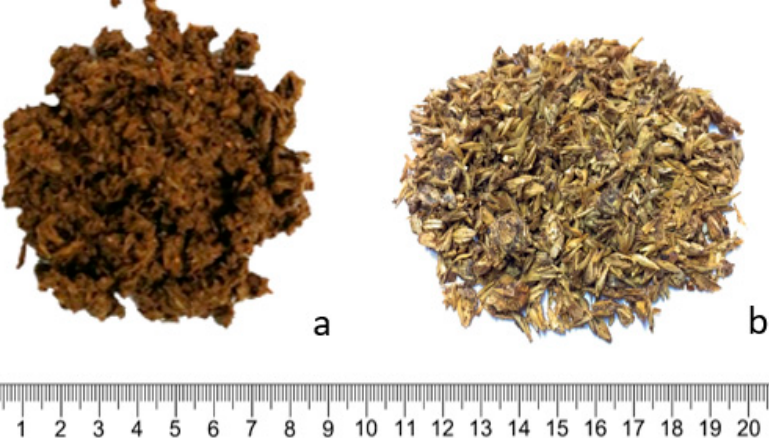
Figure 2. Brewers’ spent grain: original ( a ) and dried ( b ) samples.